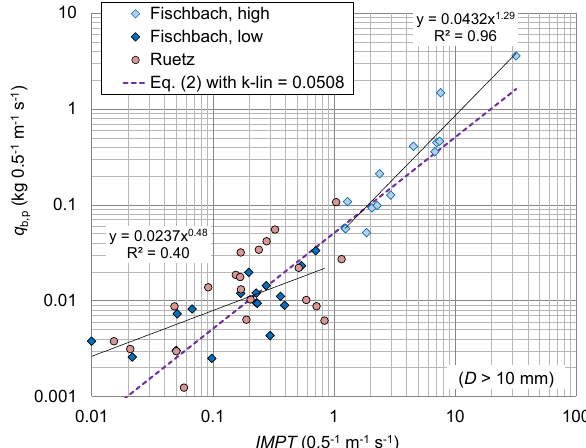
Figure 8. Characteristic grain size D 84 (determined for particles with D > 10mm) vs. bedload flux q b , derived from the calibration bedload samples (for D > 10mm). Fischbach: data points marked “high” and “low” refer to impulse rates higher and lower than 1 (0.5 − 1 m − 1 s − 1 ), respectively. The regression line is based on both the Fischbach and Ruetz data.